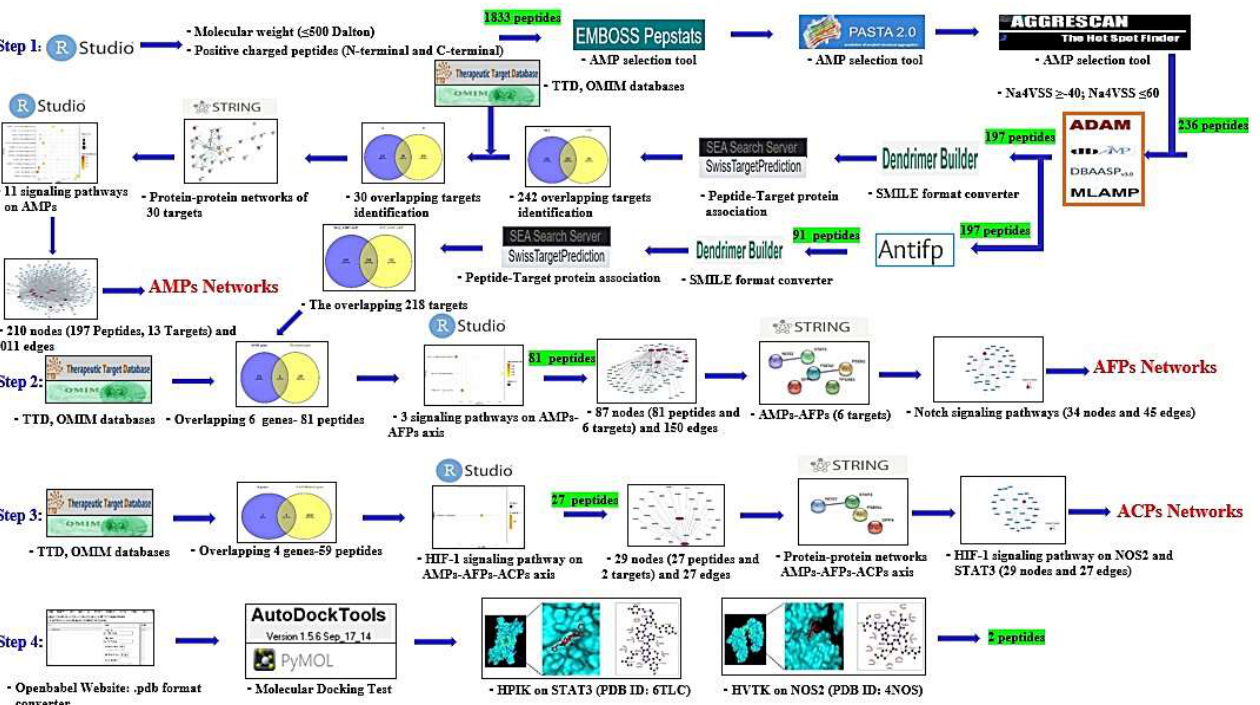
Figure 1. Workflow of AMPs ― AFPs ― ACPs’ axis analysis on network pharmacology. Green high- light: the number of peptides.